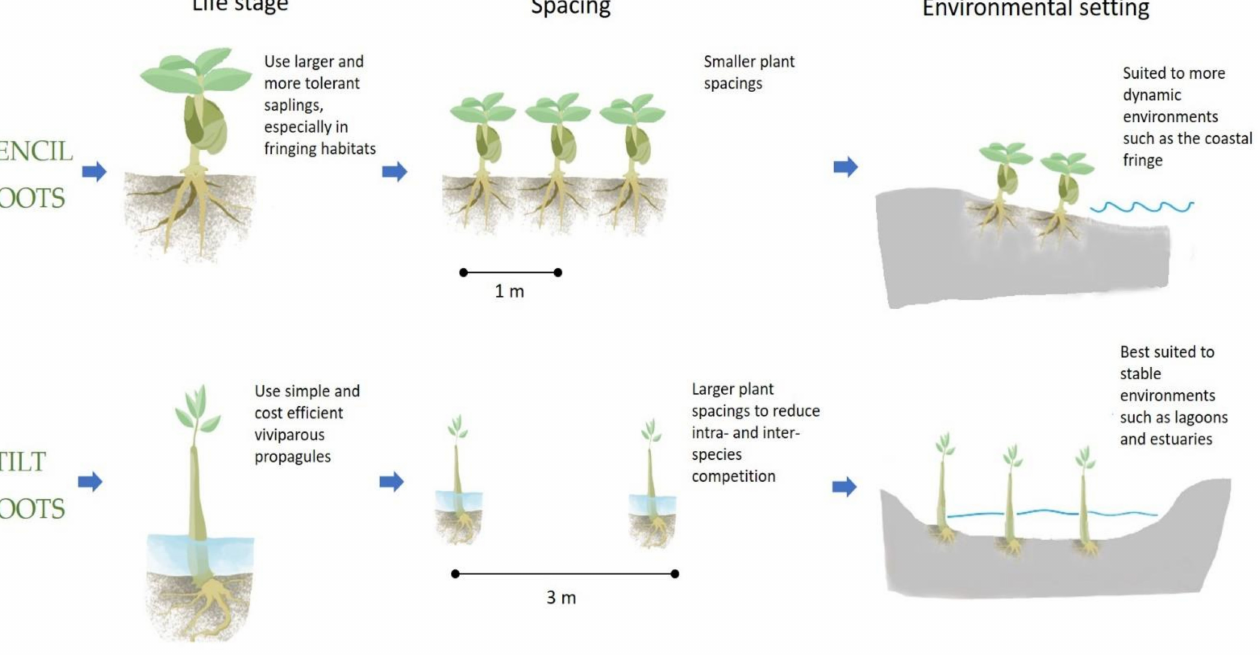
Figure 5. Restoration guidelines that can optimize survival outcomes for different morphological groups of